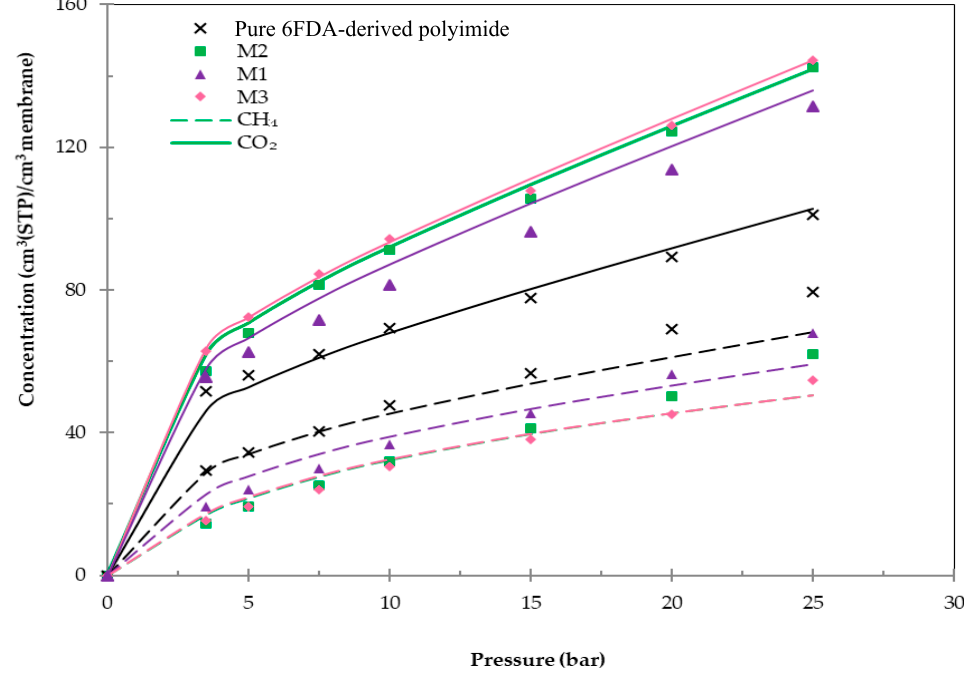
Figure 5. Sorption isotherms of pure 6FDA-derived polyimide and impregnated Linde T hybrid membranes including M1, M2, and M3 membranes at 30 °C.